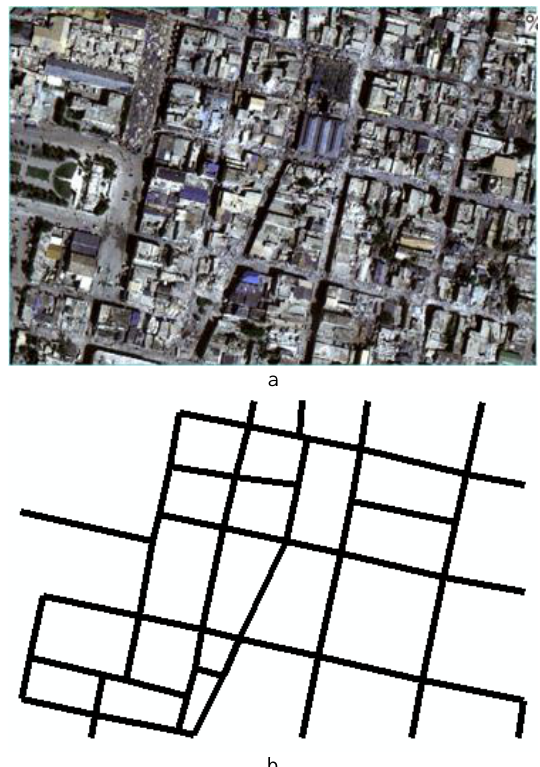
Fig 3. Study area. a. Post-event high resolution satellite imagery. b.Pre-event vector map